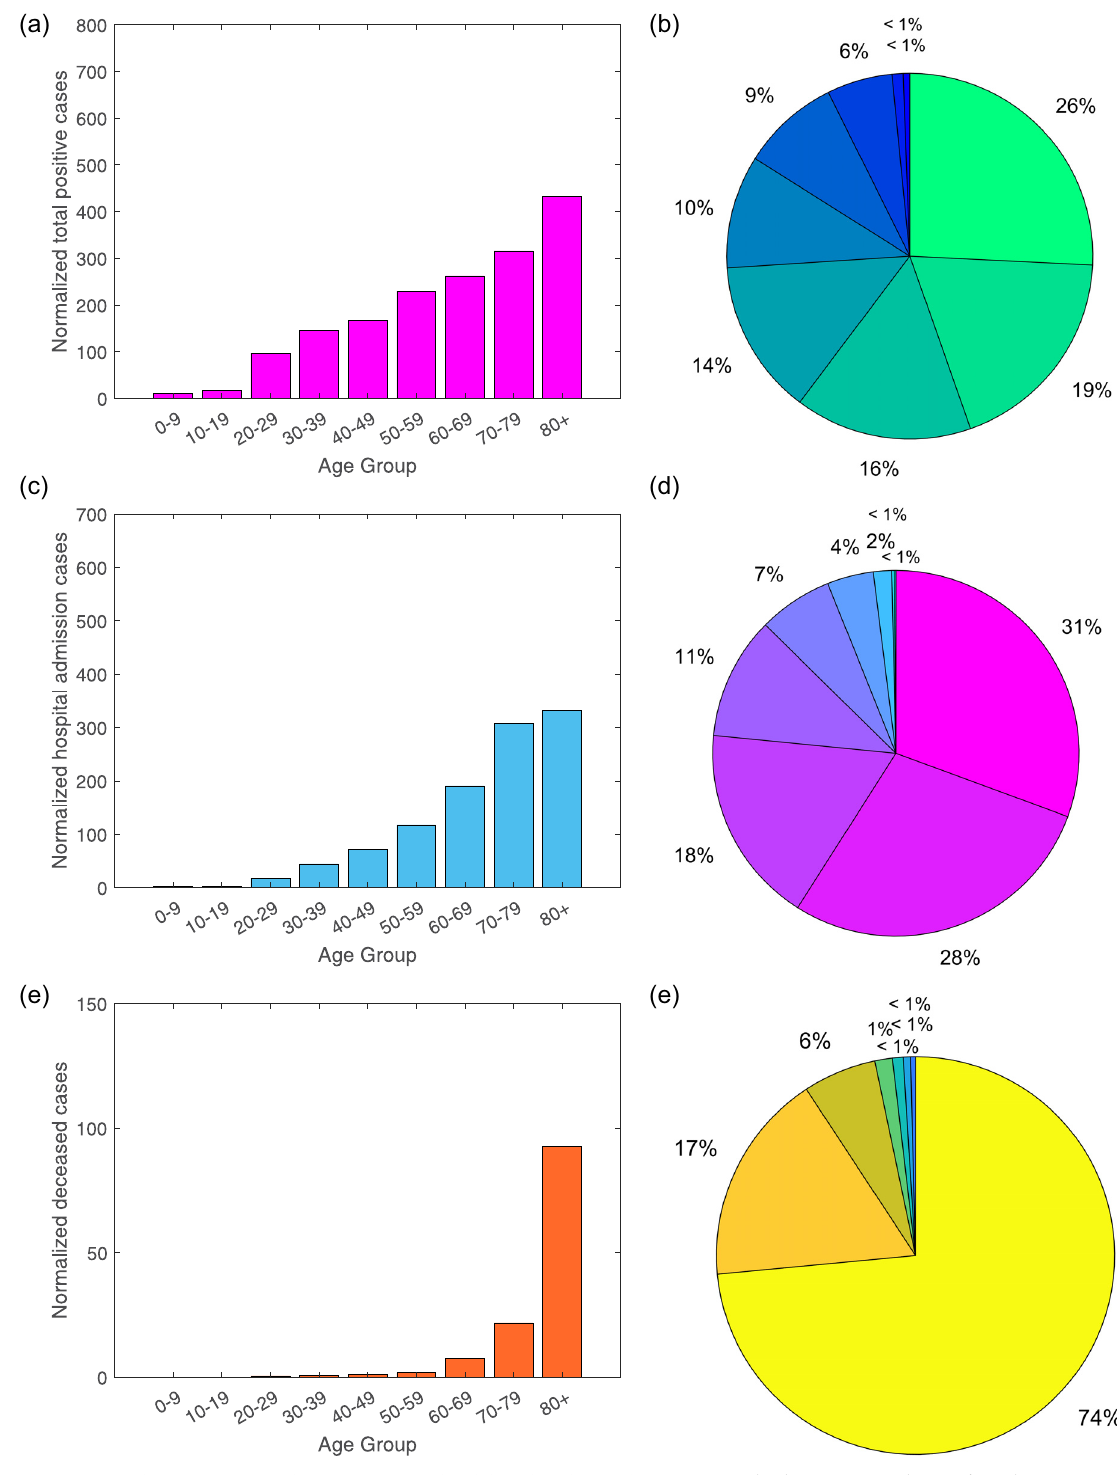
Fig 4. From February 15 to March 25, 2020, normalized data distribution by age group. The data is presented as confirmed cases per 100000 people. In (a-b) total positive cases, (c-d) hospitalized cases and (e-f) deceased cases.